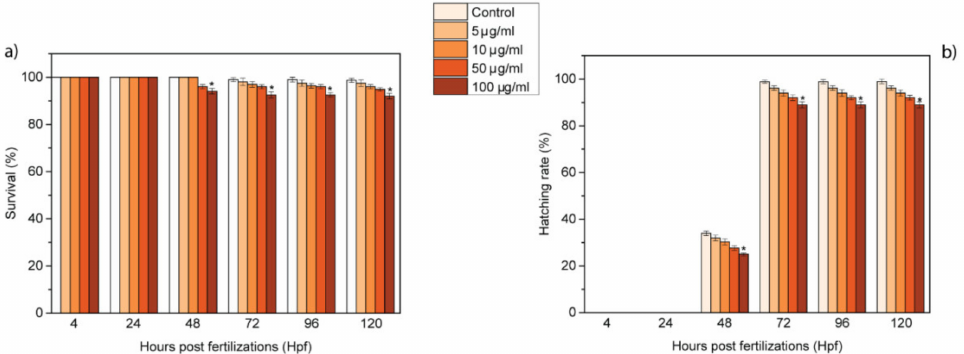
Figure 2. E ff ects of GL layers on zebrafish development. ( a ) Survival (%) and ( b ) hatching rates (%) of zebrafish treated with GL layers (* p <